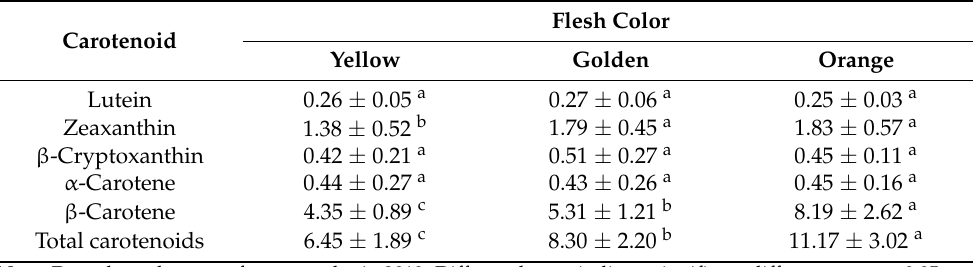
Table 5. Comparison of carotenoid content of yellow-flesh peach with different flesh colors.